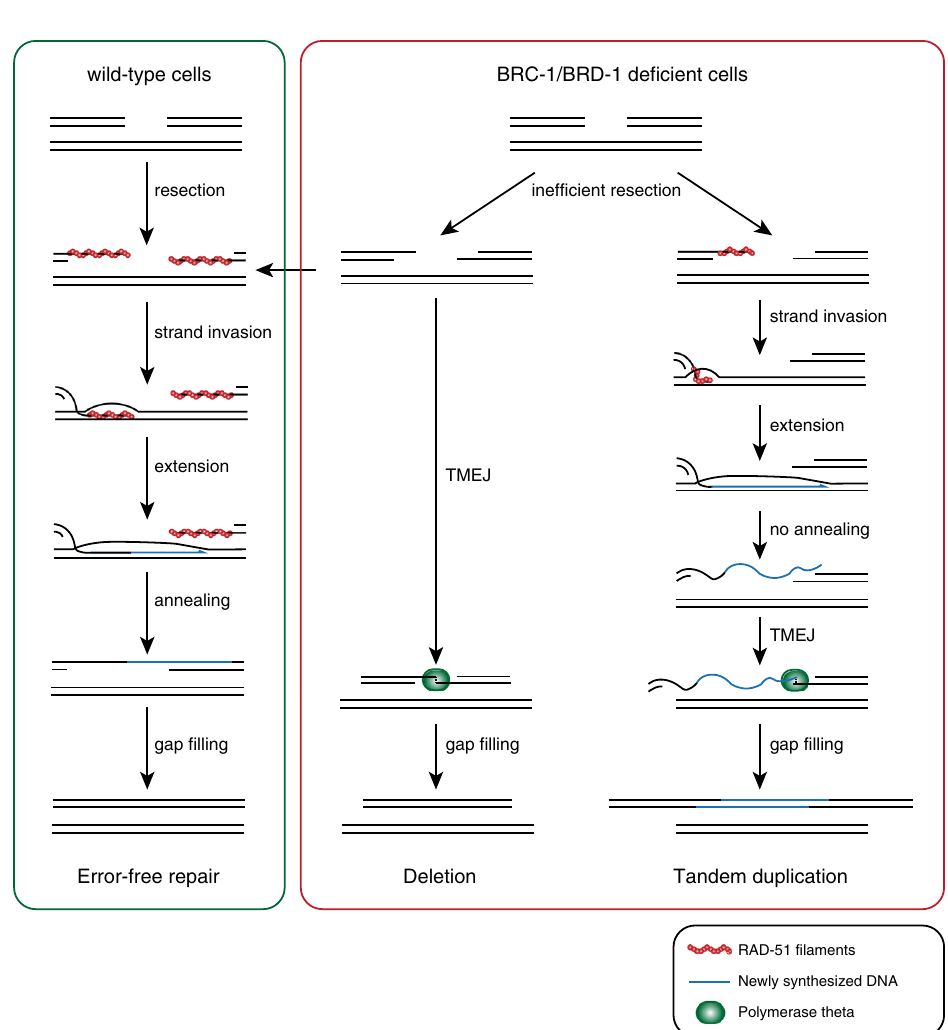
Fig. 5 Model in BRC-1/BRD-1-de fi cient cells, inef fi cient resection leads to impaired strand invasion. When strand invasion cannot occur, break ends are joined by polymerase theta. When strand invasion does occur, reannealing of the extended invaded strand can be hindered by insuf fi cient resection of the receiving strand, again leading to direct end-joining by polymerase theta. When both break ends are suf fi ciently resected, error-free repair can take place, similar to repair in wild-type